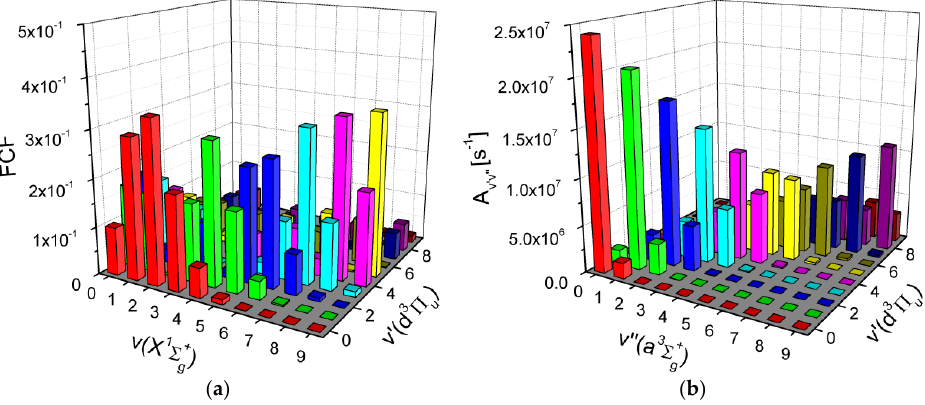
Figure 7. ( a ) Franck–Condon factors (FCF) for excitation from the ground state X 1 to the excited state d 3 in the triplet system; ( b ) A ik for spontaneous emission from d 3 to a 3 .